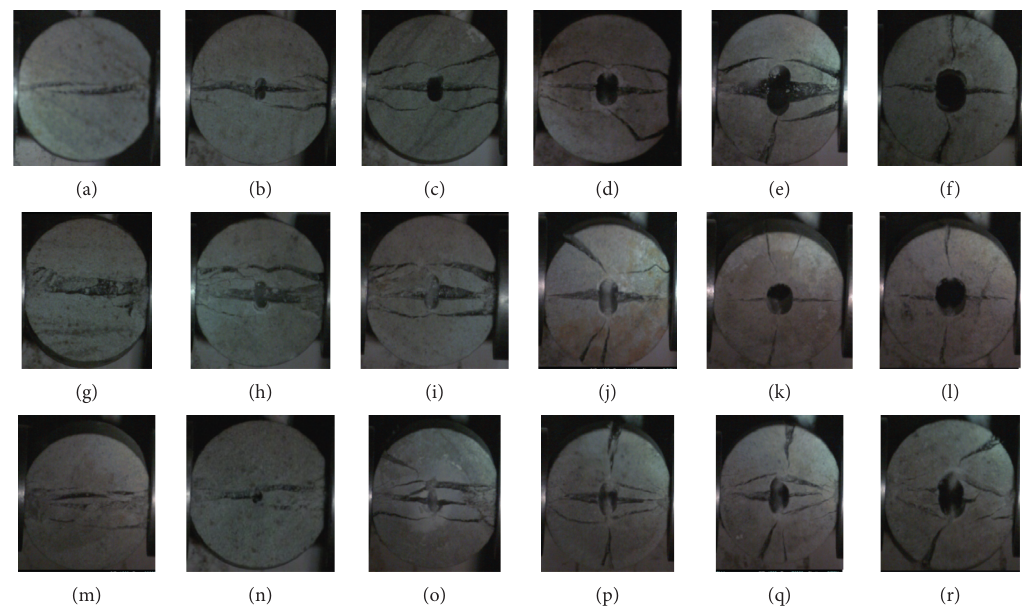
Figure 7: Final failure modes of sandstone specimens: (a) p � 0 . 15 MPa, d/D � 0; (b) p � 0 . 15 MPa d/D � 0.08; (c) p � 0 . 15 MPa, d/D � 0.12; (d) p � 0 . 15 MPa, d/D � 0.16; (e) p � 0 . 15 MPa, d/D � 0.2; (f) p � 0 . 15 MPa, d/D � 0.24; (g) p � 0 . 3MPa, d/D � 0; (h) p � 0 . 3MPa, d/ D � 0.08; (i) p � 0 . 3MPa, d/D � 0.12; (j) p � 0 . 3MPa, d/D � 0.16; (k) p � 0 . 3MPa, d/D � 0.2; (l) p � 0 . 3 MPa, d/D � 0.24; (m) p � 0 . 5MPa, d/D � 0; (n) p � 0 . 5MPa d/D � 0.08; (o) p � 0 . 5MPa, d/D � 0.12; (p) p � 0 . 5MPa, d/D � 0.16; (q) p � 0 . 5MPa, d/D � 0.2; (r) p � 0 . 5MPa, d/ D � 0.24.